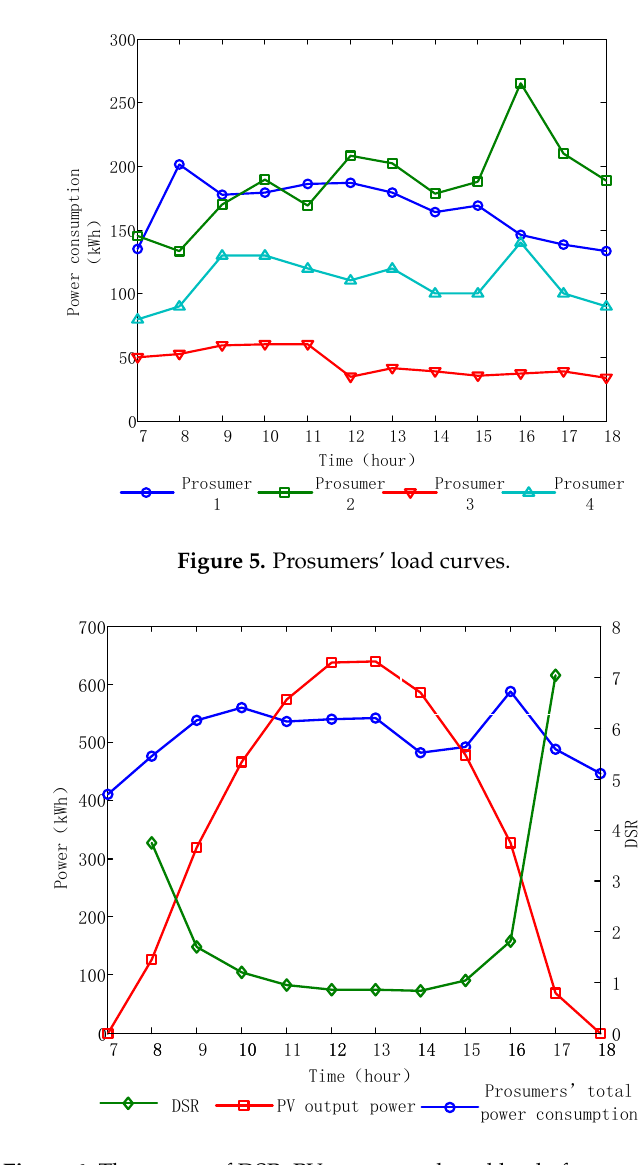
Figure 6. The curves of DSR, PV energy, and total load of prosumers.